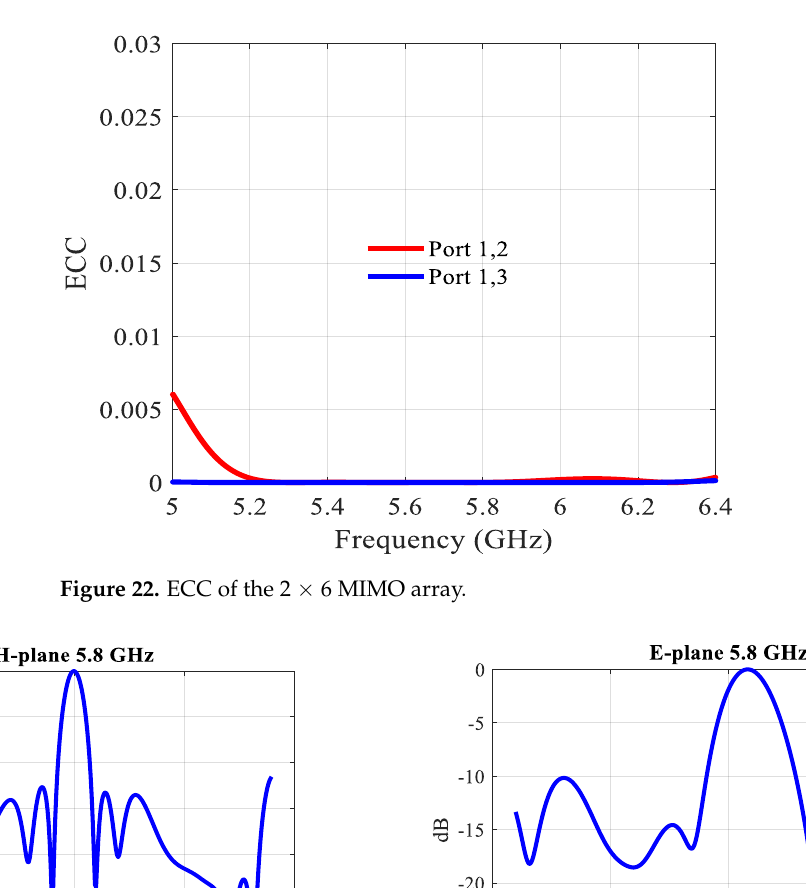
Figure 21. Simulated S-parameters of the 2 × 6 array with 3 ports.